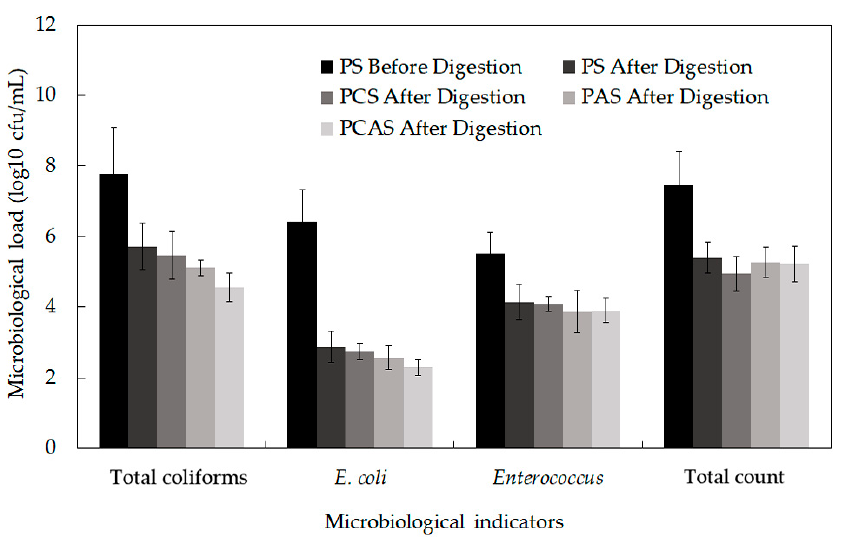
Figure 9. Colony forming units (cfu) of total coliforms, Escherichia coli , Enterococcus , total microbio- logical count, for the substrates PS, PCS, PAS, PCAS (error bars indicate standard deviation of mean values).